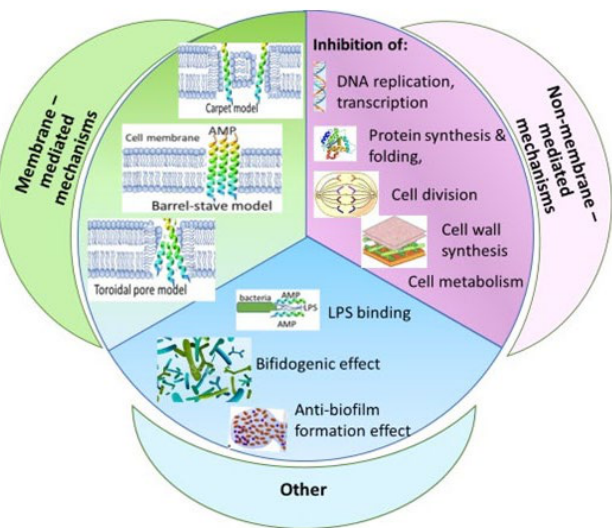
Figure 1. Mechanisms of antimicrobial actions of human antimicrobial peptides.